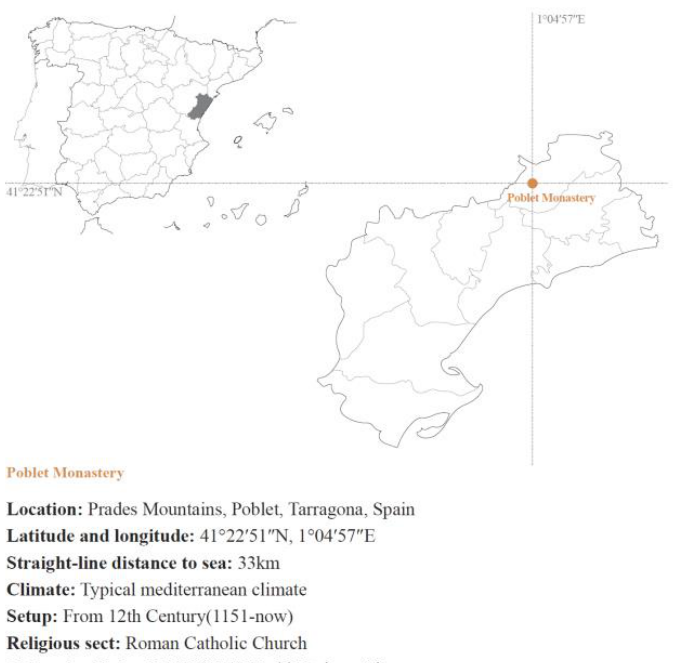
Figure 7. Diagram of the location of Poblet Monastery.